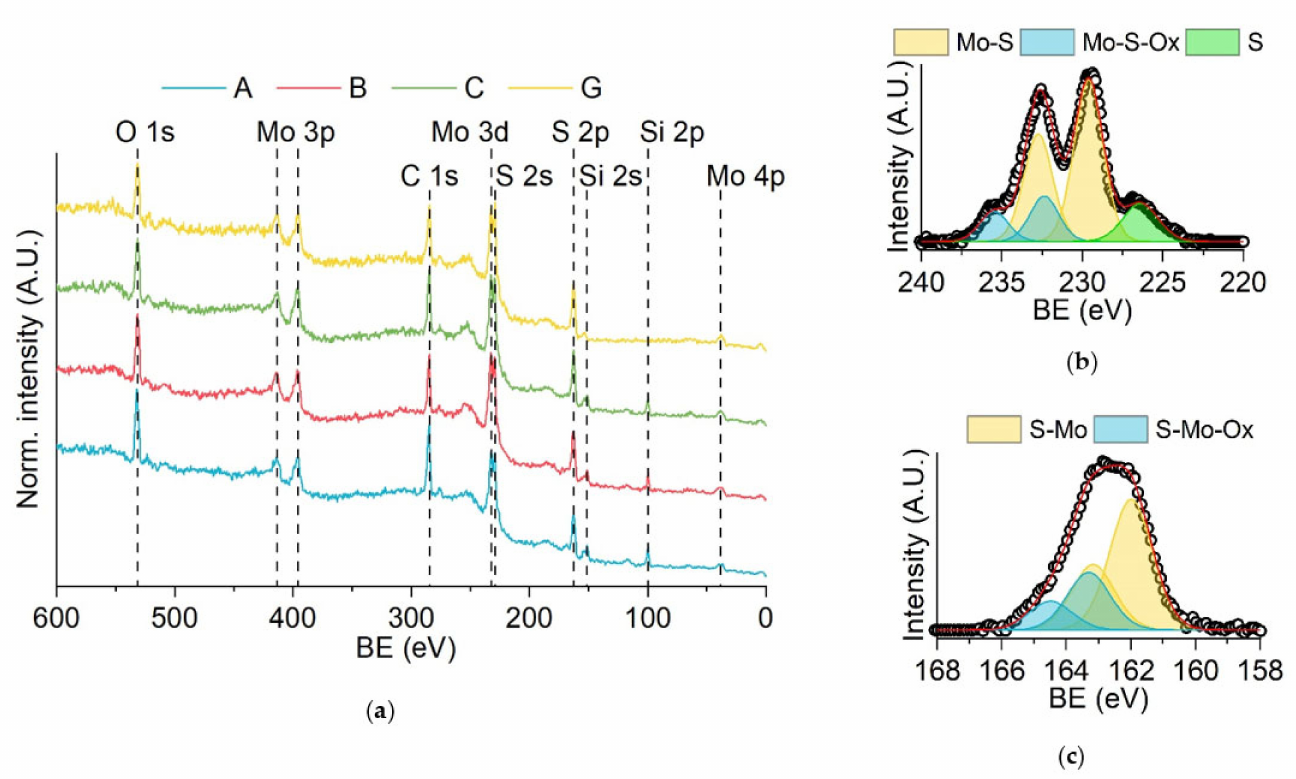
Figure 2. XPS spectra of the samples: ( a ) surveys of samples A, B, C and G; ( b ) high-resolution spectra of sample A in the Mo 3d region; ( c ) high-resolution spectra of sample A in the S 2p